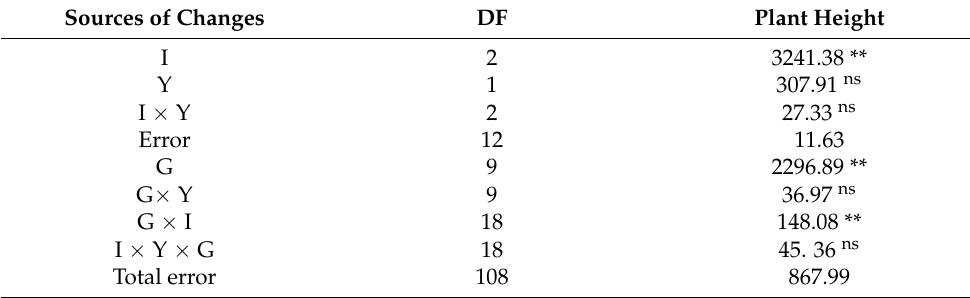
Table 8. Analyses of variance at three irrigation regimes (I) in two years (Y). Sources of